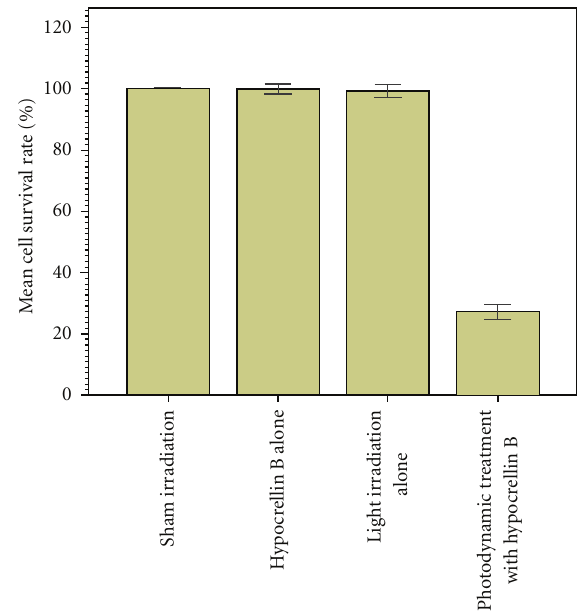
Figure 1: Cell survival rate of HO-8910 cells was measured using MTT 24h after photodynamic action of hypocrellin